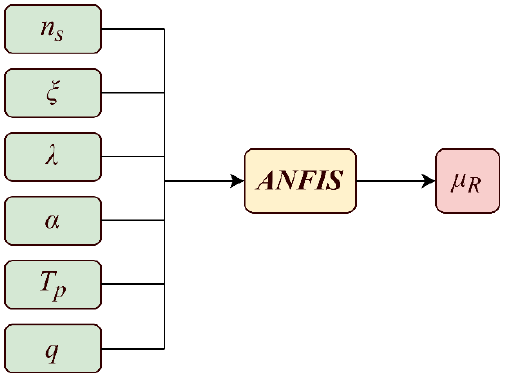
Figure 6. Schematic of the input and output parameters of the